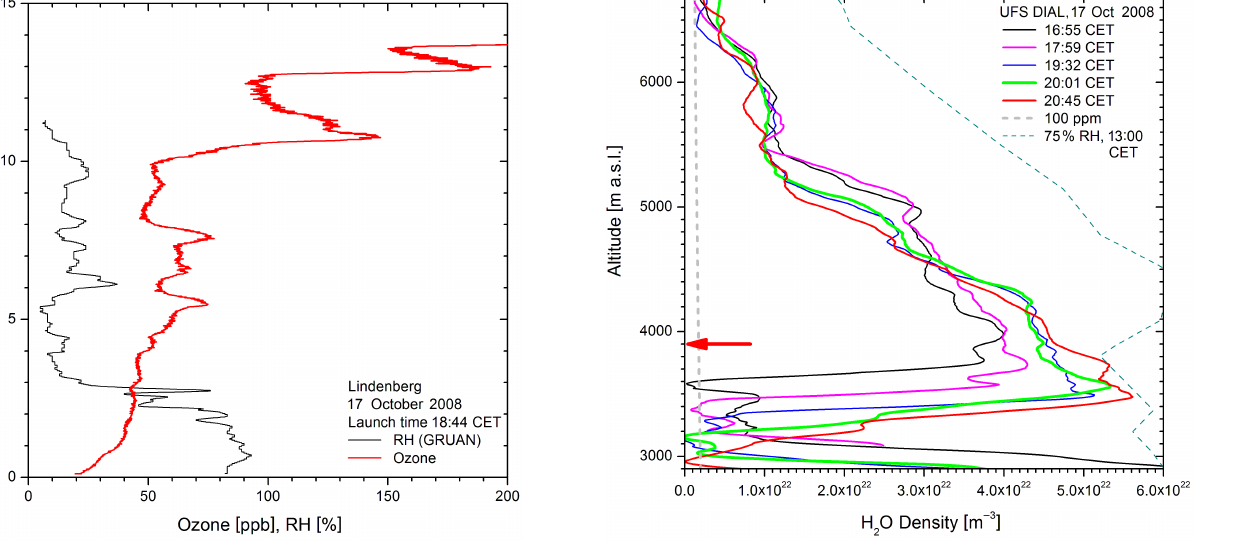
Figure 10. Water-vapour profiles from the measurements of Zugspitze DIAL on 17 October 2008; the red arrow marks the verti- cal position of the RH minimum (1%) from the noon “Munich” ra- diosonde, observed during the ascent at 11:56CET. The grey dashed line marks a mixing ratio of 100ppm as determined from the same sonde ascent. In addition, a density profile for 75% RH is given for a crude comparison (Munich, 13:00CET). The corresponding pro- file for the following midnight shows significantly higher RH below 4.5km since the intrusion had subsided to 2.78km and, therefore, is not included here.